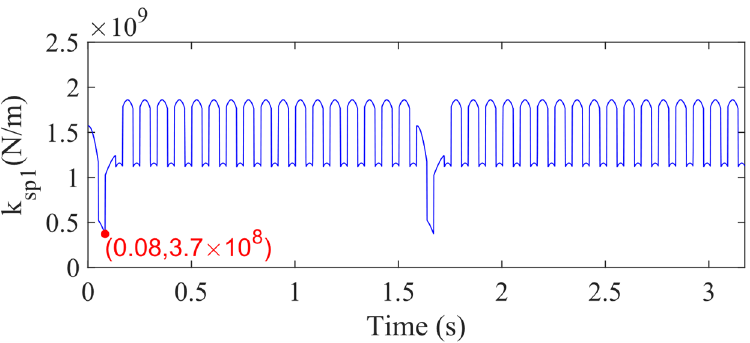
Figure 9. Meshing stiffness of sun-planet 1 with 50% sun gear tooth crack. Table 4. Parameters of the modeled planetary gearbox [29].